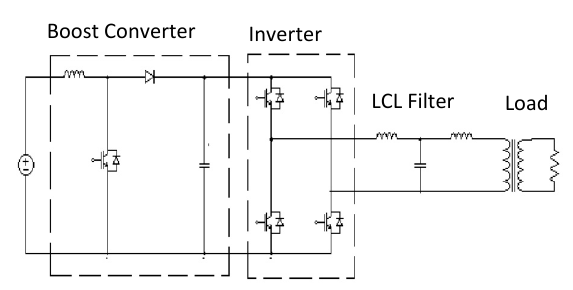
Figure 1. Photovoltaic system in island mode.